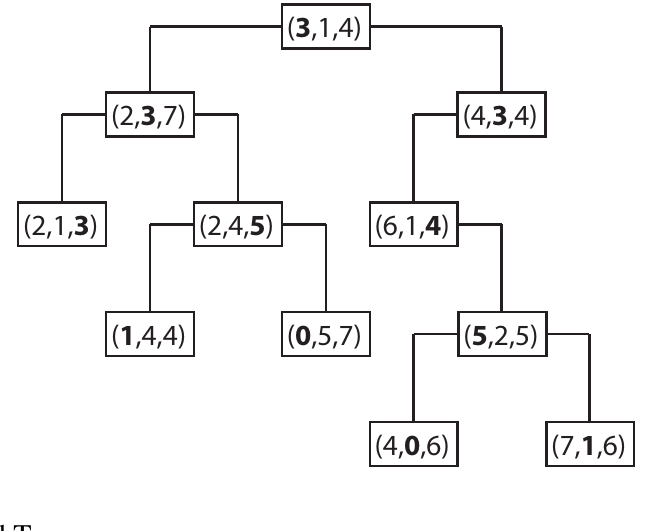
Figure 2. A sample k-d tree that stores points in three-dimensional